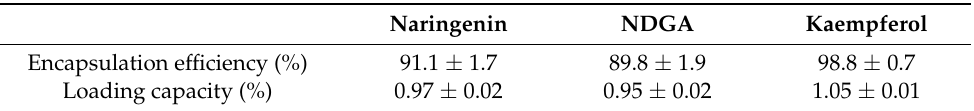
Table 3. Encapsulation efficiencies and loading capacity of naringenin, NDGA, and kaempferol in the NLCs (mean ± SD, n = 3).